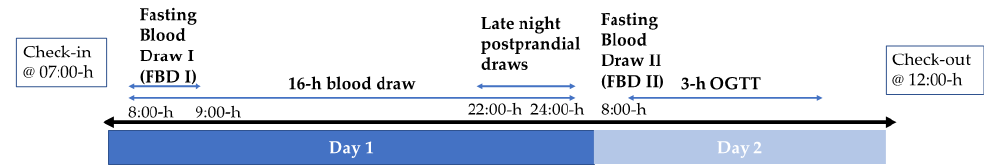
Figure 1. Schematic of 2-day inpatient visits. Oral glucose tolerance test (OGTT). Sample analyses: Plasma concentrations of TG, uric acid, glucose, and insulin were measured at all time points and the 16-h total area under the curves (AUC) were calcu- lated by the trapezoidal method. The concentrations of cholesterol, LDL-C, non-HDL-C,